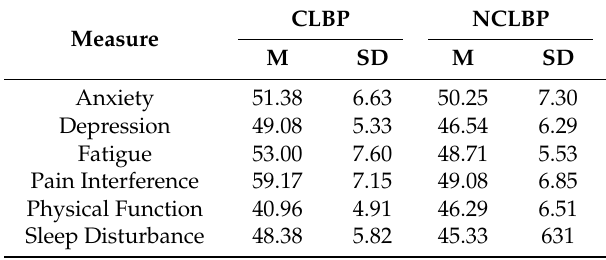
Table 2. Patient-Reported Outcome Measurement Information System (PROMIS) data